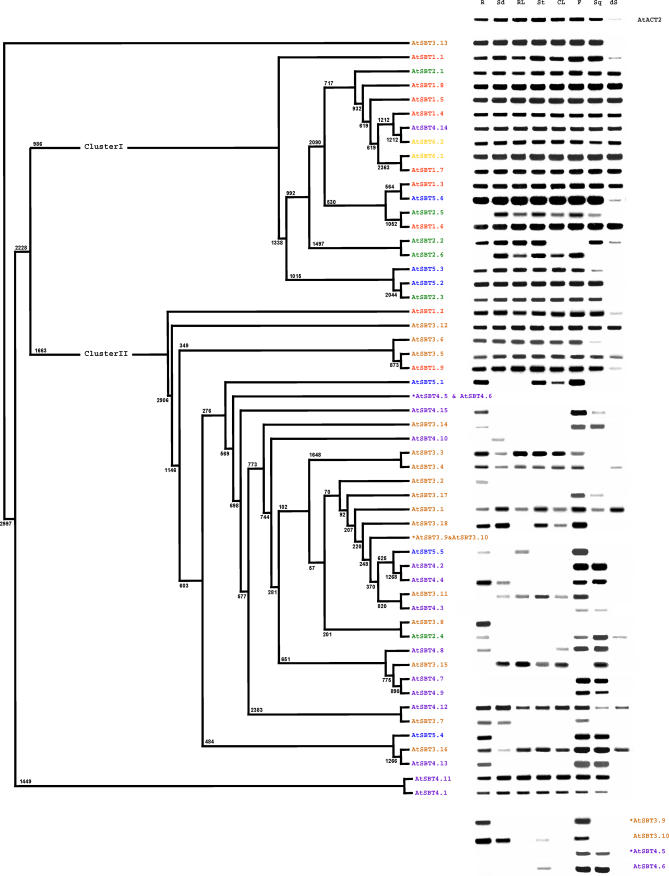
Bootstrapped Consensus Cluster Tree from Converted Detection Call Matrix of Affymetrix (Ath1) Microarray Experiments into Boolean Values (AtGenExpress Developmental Series)Cluster I covers ubiquitously expressed genes, whereas Cluster II mainly represents lowly or specifically expressed genes. These results were validated independently by semi-quantitative RT-PCR analysis (shown in the right panel). CL, cauline leaves; dS, dry seed; F, flower; R, root; RL, rosette leaves; Sd, seedling; Sq, siliques; St, inflorescence stem.